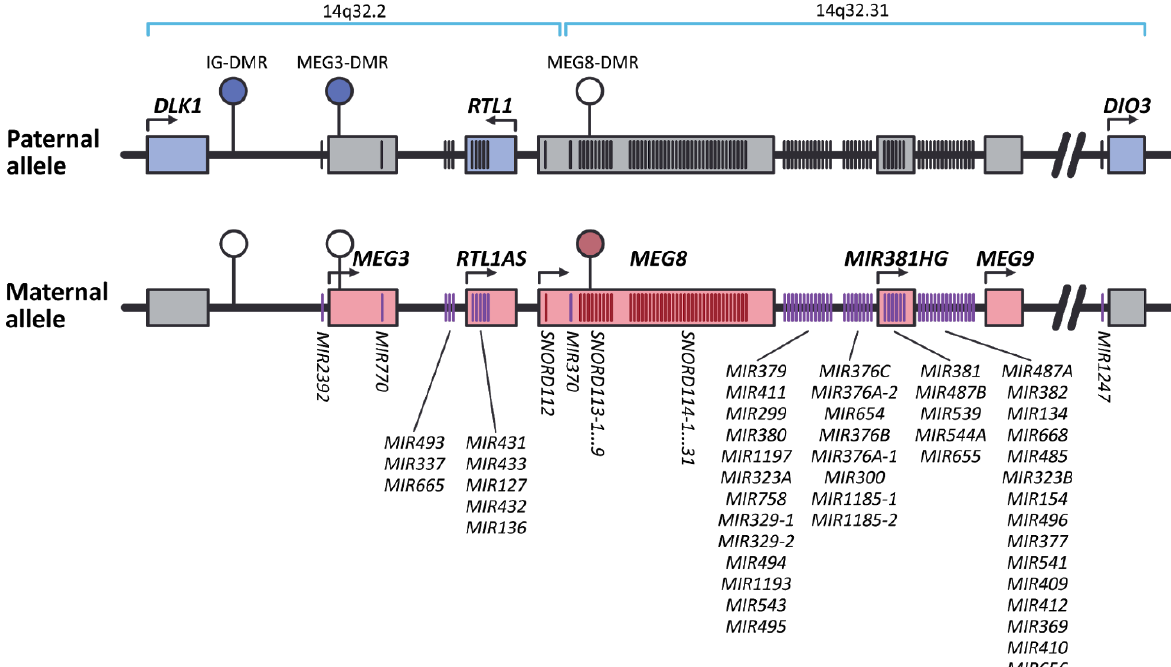
Figure 1. The schematic representation of the locus DLK1-DIO3 (based on genome assembly GRCh38.p12). The imprinted locus DLK1-DIO3 contains paternally-expressed protein-coding genes: DLK1 , DIO3 , and RTL1 genes (blue rectangles) and maternally-expressed genes of long noncoding RNAs: MEG3 , MEG8 , MEG9 , and RTL1AS (red rectangles). MEG8 contains a tandemly repeating array of small nucleolar RNAs (snoRNAs) of C/D-box family, namely SNORD112 , SNORD113 , and SNORD114 , consisting of one, nine, and 31 paralogous genes of snoRNAs, respectively. The locus also includes two large clusters of microRNA (miRNA) genes (10 miRNA genes in 14q32.2 and 44 miRNA genes in 14q32.31), expressed from the maternal allele. IG-DMR and MEG3-DMR are methylated on the paternal chromosome, while MEG8-DMR, in contrast, is methylated on the maternal chromosome. Filled ellipses represent methylated DMRs, and open ellipses represent unmethylated DMRs. Gray boxes and black strokes indicate non-expressing genes. Transcriptionally-active genes are marked with colored boxes and strokes; purple and red strokes are miRNA and snoRNA genes, respectively.